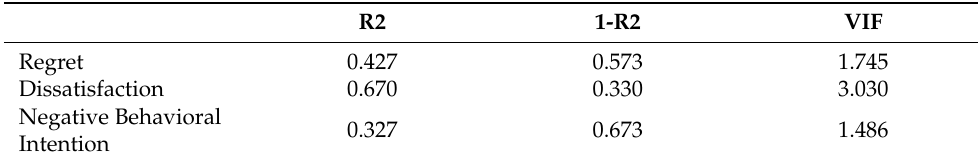
Table 2. Result of variance inflation factor (VIF).